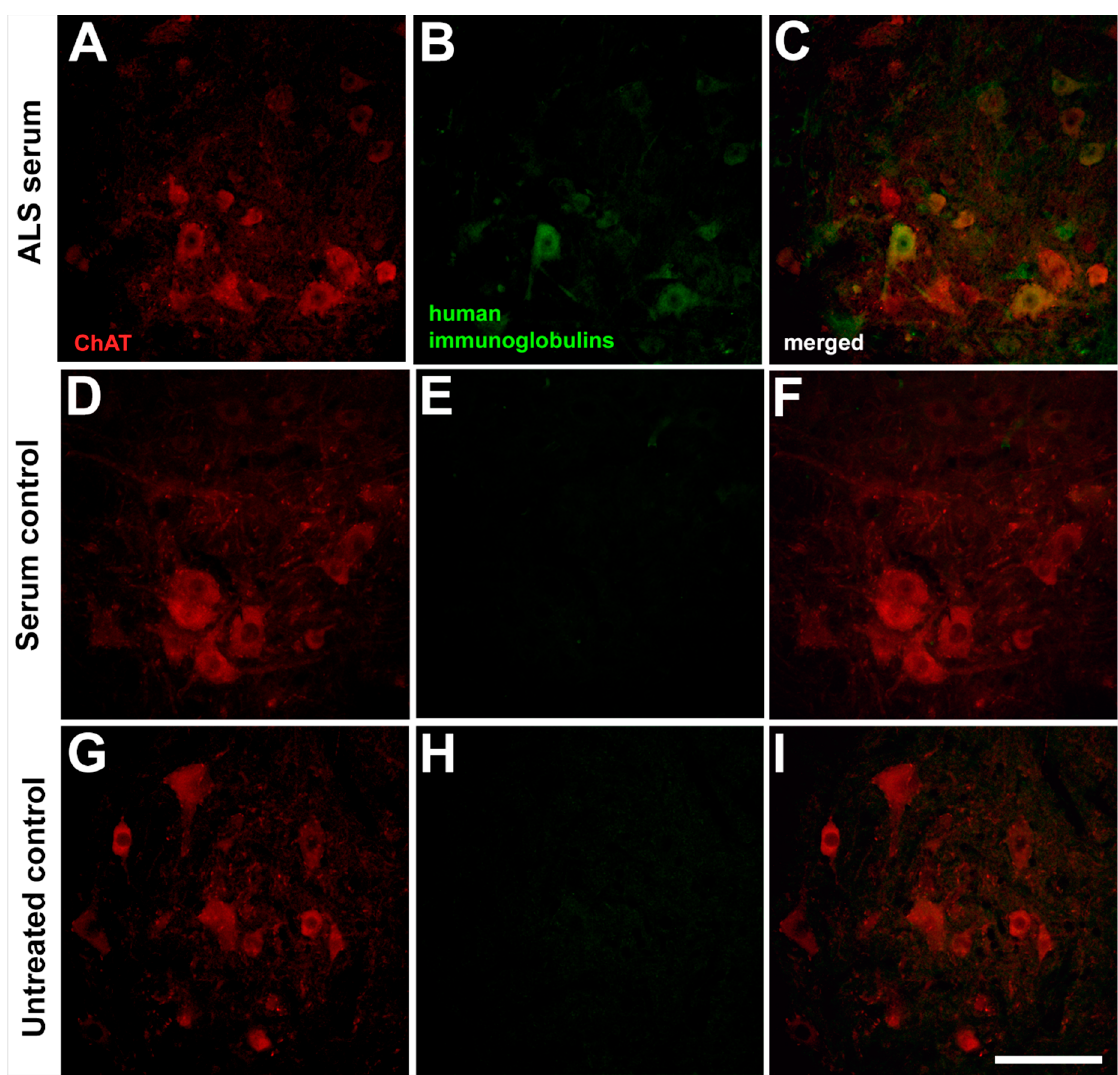
Figure 1. The presence of human immunoglobulins in spinal motor neurons (MNs) can be detected after intraperitoneal injection of sera from amyotrophic lateral sclerosis patients ( C ). The ventrolateral pool of MNs was demonstrated with choline acetyltransferase (ChAT) staining ( A , D , G ). Presence of immunoglobulins can be detected in sections cut from ALS-treated mice ( B ), and were not present in sections obtained from healthy-serum-treated ( E ) or untreated control animals ( H ). Merged images ( C , F , I ) show the colocalization of human immunoglobulins with MNs of ALS serum-treated mice only. Scale bar: 200 µm .